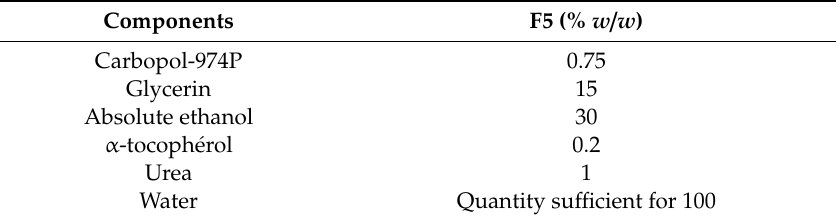
Table 1. Composition of rapamycin hydro-alcoholic gel formulation